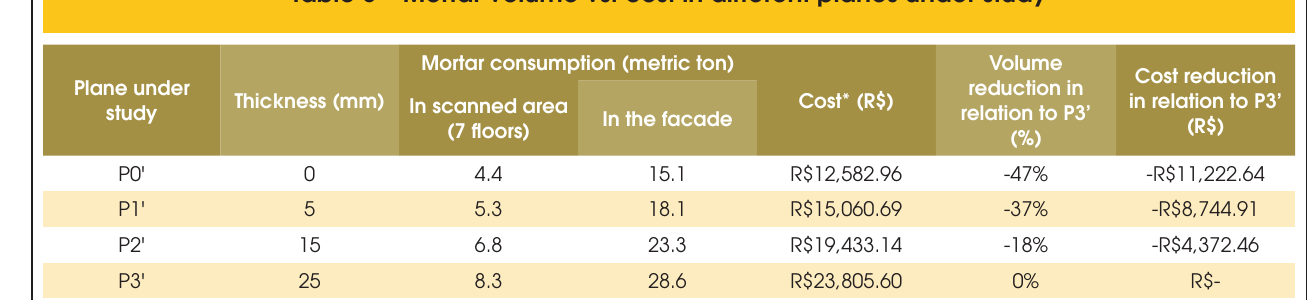
Table 5 – Mortar volume vs. cost in different planes under study